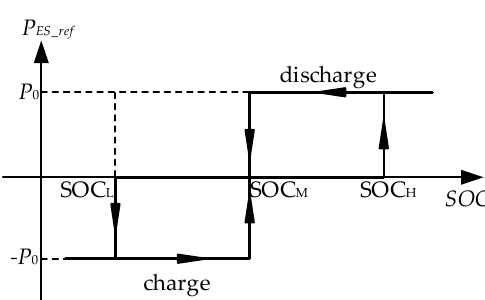
Figure 2. Relationship between exchanged power reference and SOC.